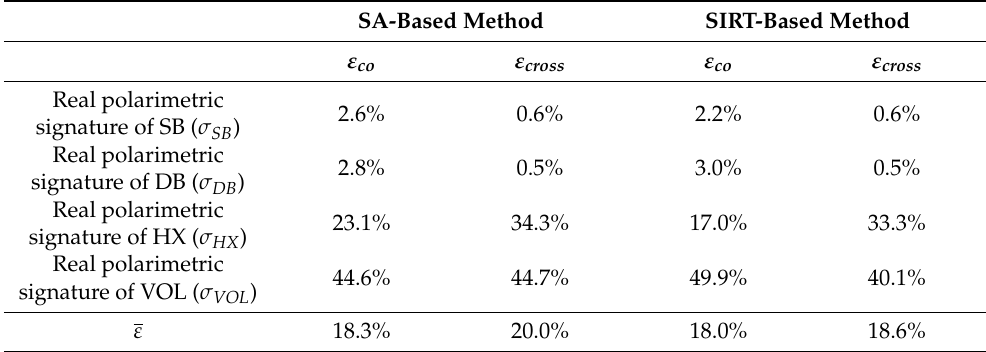
Table 11. Inaccuracies for SA- and SIRT-based decompositions for real polarimetric signatures. Recognized signatures are specified in